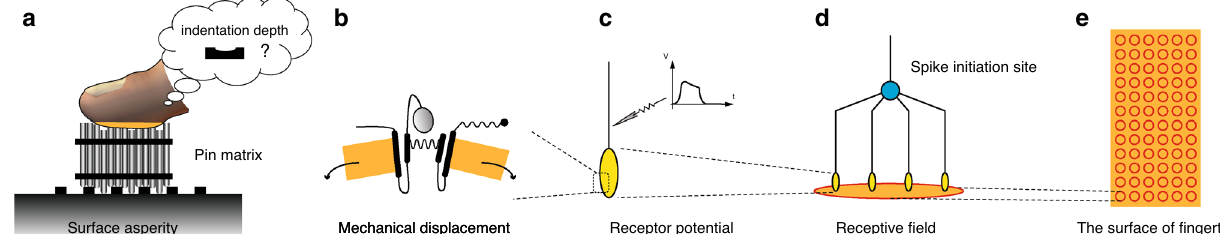
Figure 3. Mathematical model. ( a ) A pin of the pin matrix produces skin deformation that leads to ( b ) opening a mechanosensitive ion channel in a mechanoreceptor. ( c ) Change in receptor potential due to the mechanoreceptor’s physiological response is conveyed electrically to a spike initiation site ( d ) where four mechanoreceptors are connected. This mechanoreceptor-sensory neuron system works as ( e ) a responsive receptive field distributed uniformly in the fingertip. After calculating the responses of multiple receptive fields, both the firing rate of each receptive field and the firing timing synchronicity (the Shannon entropy) over multiple receptive fields are calculated. The concept of the process of mechanoreception is developed based on proposals in the existing literature 29,38,39